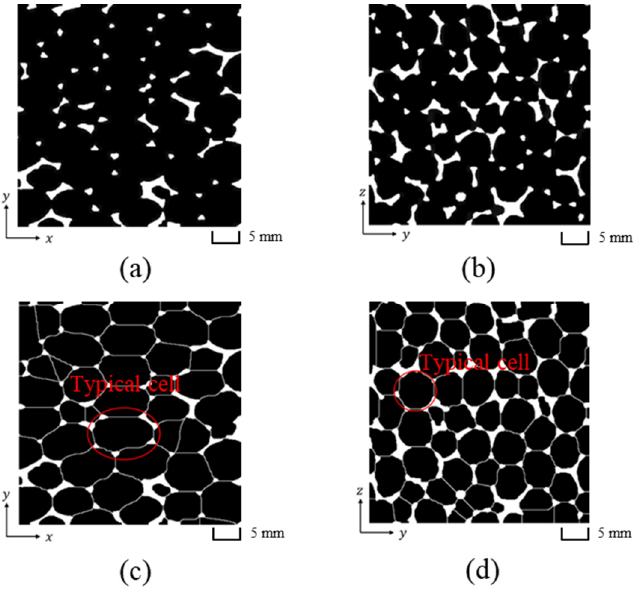
Figure 3. The original pictures: ( a ) xy plane; ( b ) yz plane and distributions of cells for Feret diameter evaluation: ( c ) xy plane; ( d ) yz plane.